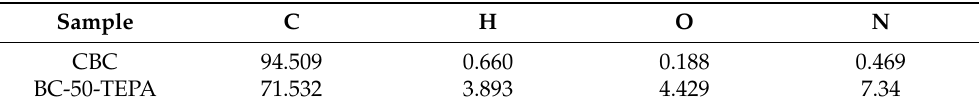
Table 3. Elemental analysis of CBC and CBC-50-TEPA ( wt